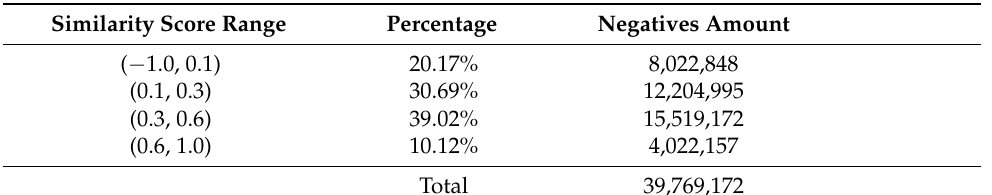
Table 5. The distribution of the similarity scores between queries and generated queries. The distribution is important evidence for the threshold selection in the negative selection method and the data augmentation method, which indicate the degree of confidence of the selected data. The similarity scores are calculated through sentence-BERT